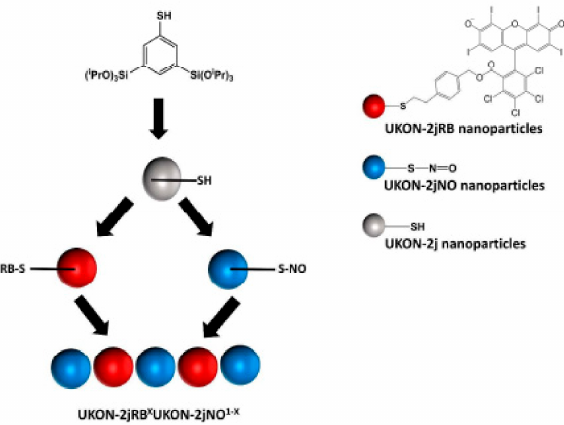
Figure 14. Graphical representation of the relative survival rate of the different NPs functionalized with different quaternary amines. Retrieved from